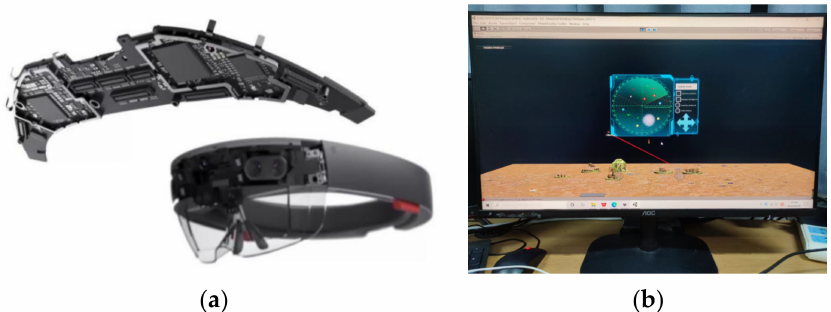
Figure 1. Display device (( a ) Mixed reality display: HoloLens2; ( b ) Two dimensional display: AOC displayer).